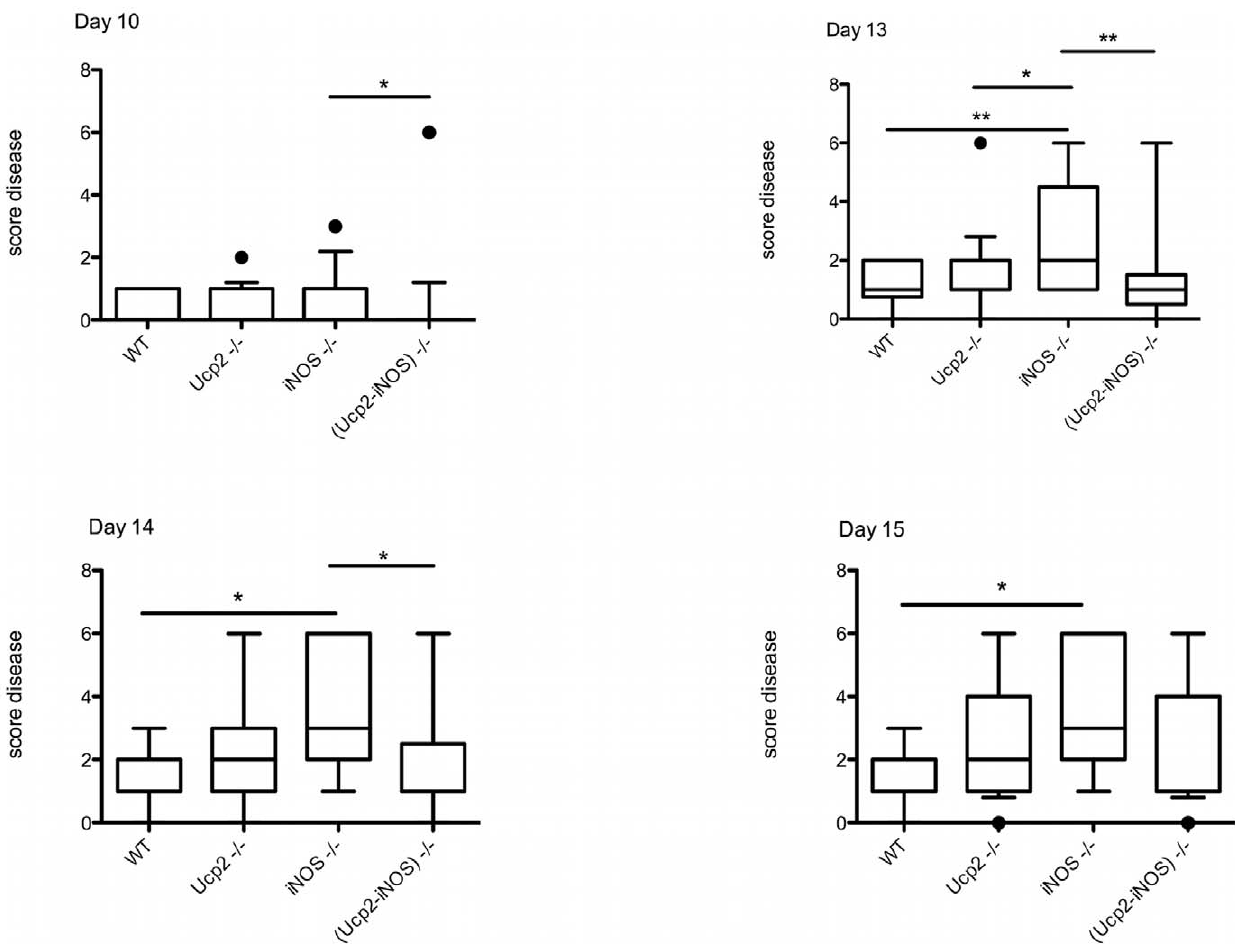
Figure 1. Score disease of mice upon EAE induction. EAE was induced in 7–10 weeks of age mice by subcutaneous injection with 150 m g MOG 35–55 peptide in presence of Freund adjuvant and Pertussis toxin (see Material and Methods). Clinical symptoms were scored as follows: 0, normal; 1, weak/flaccid tail; 2, waddle; 3, moderate paraparesis; 4, severe paraparesis; 5, tetraparesis; 6, moribund. The mean clinical score was determined as the average score of all animals for a given genotype at days 10, 13, 14 and 15. Statistical significance was determined by one way ANOVA and free parametric Kruskal-Wallis test. *, P , 0.05; **, P , 0.01; ***, P , 0.001.